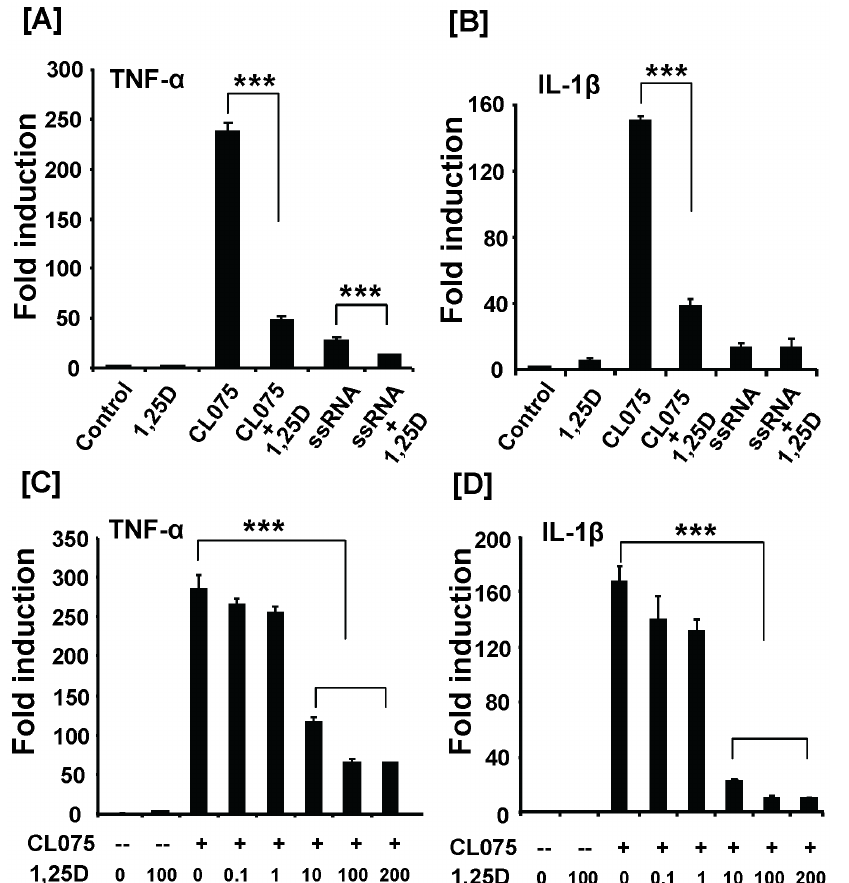
Figure 5. 1,25(OH) 2 D 3 inhibits TLR8-mediated inflammatory cytokine expression in human THP-1 monocytes. ( A–B ) Human monocyte THP-1 cells were pretreated with 1,25(OH) 2 D 3 (100 nM) for 30 min and then stimulated with CL075 (1 m g/ml) or ssRNA (5 m g/ml) for 20 h. ( C–D ) THP- 1 cells were pretreated with different doses of 1,25(OH) 2 D 3 (0.1–200 nM) for 30 min and then incubated with CL075 (1 m g/ml) for additional 20 h. TNF- a and IL-1 b mRNA levels were measured by real-time RT-PCR. Data shown are means 6 SEM (n=4) and are representative of three independent experiments. *** P , 0.001.